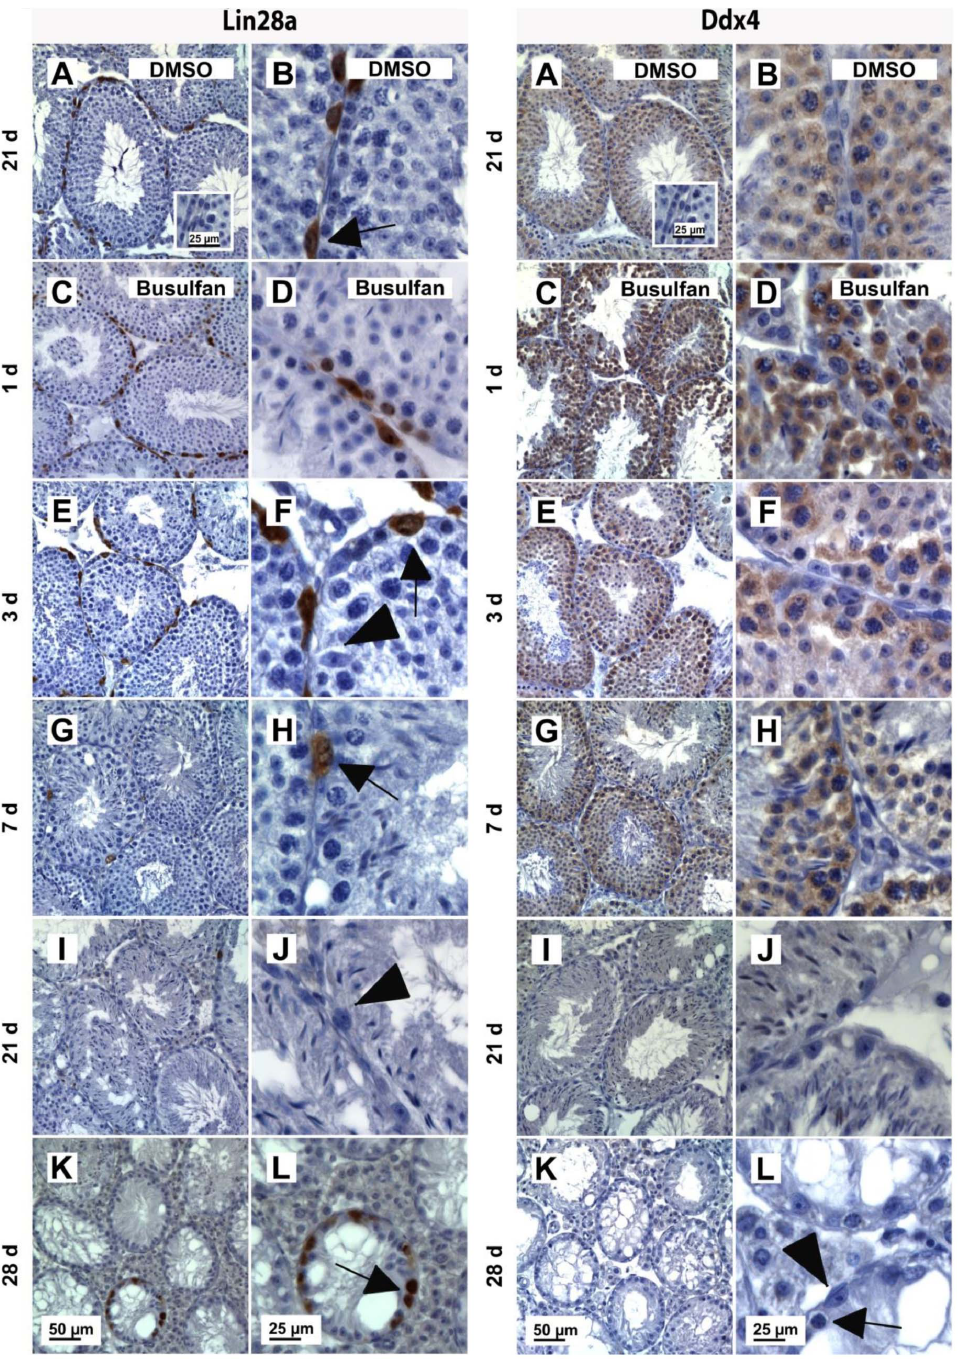
Figure 3. Expression of Lin28a and Ddx4 in adult mouse testes following busulfan treatment. Representative images showing immunohistochemical stainings for Lin28a (left column) and Ddx4 (right column) on testis sections of DMSO (A, B) and busulfan treated (C–L) adult mice. For Lin28a and Ddx4 stainings on days 1 (C), 3 (E), 7 (G), 21 (I) and 28 (K) after busulfan treatment higher magnifications are shown for each time point (D, F, H, J, L). Germ cells are indicated by arrows and Sertoli cells by arrow heads. As negative control, stainings with nonspecific IgGs were performed (A; Insert). Scale bars represent 25 m m and 50 m